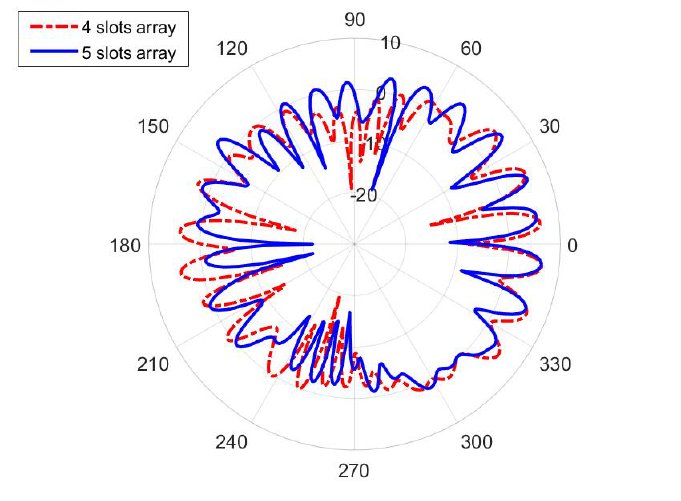
Figure 12. Radiation pattern in the H-plane ( xy -plane) of the slotted waveguide array placed hor- izontally on the human phantom with a circular cross-section (smart belt application). Both cases of the array with four slots (positioned at coordinates ϕ = 30 ◦ ,150 ◦ ,210 ◦ , and 330 ◦ ) and with five slots (positioned at coordinates ϕ = 30 ◦ ,150 ◦ ,180 ◦ ,210 ◦ , and 330 ◦ ) are shown. Radial scale is in dB, angular is in